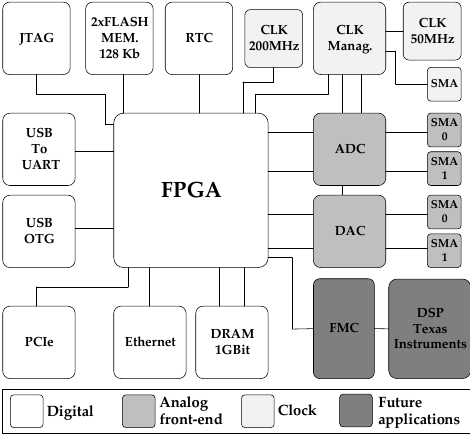
Figure 1. Block Diagram of the IRIS